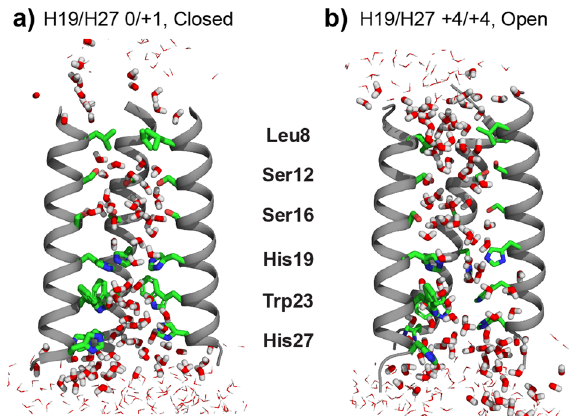
Fig. 1 Equilibrated BM2 structures in the POPE membrane. a Closed channel with the His19 and His27 tetrads in the 0 and + 1 charge states, respectively, to mimic their protonation states at high pH. b Open channel with both His19 and His27 tetrads in the + 4 charge state to mimic their protonation states at low pH. For clarity, only three out of four helices are shown. Pore-lining residues Leu8, Ser12, Ser16, His19, Trp23, and His27 are shown as sticks. Water in the channel lumen is shown as sticks while water outside the channel is shown as